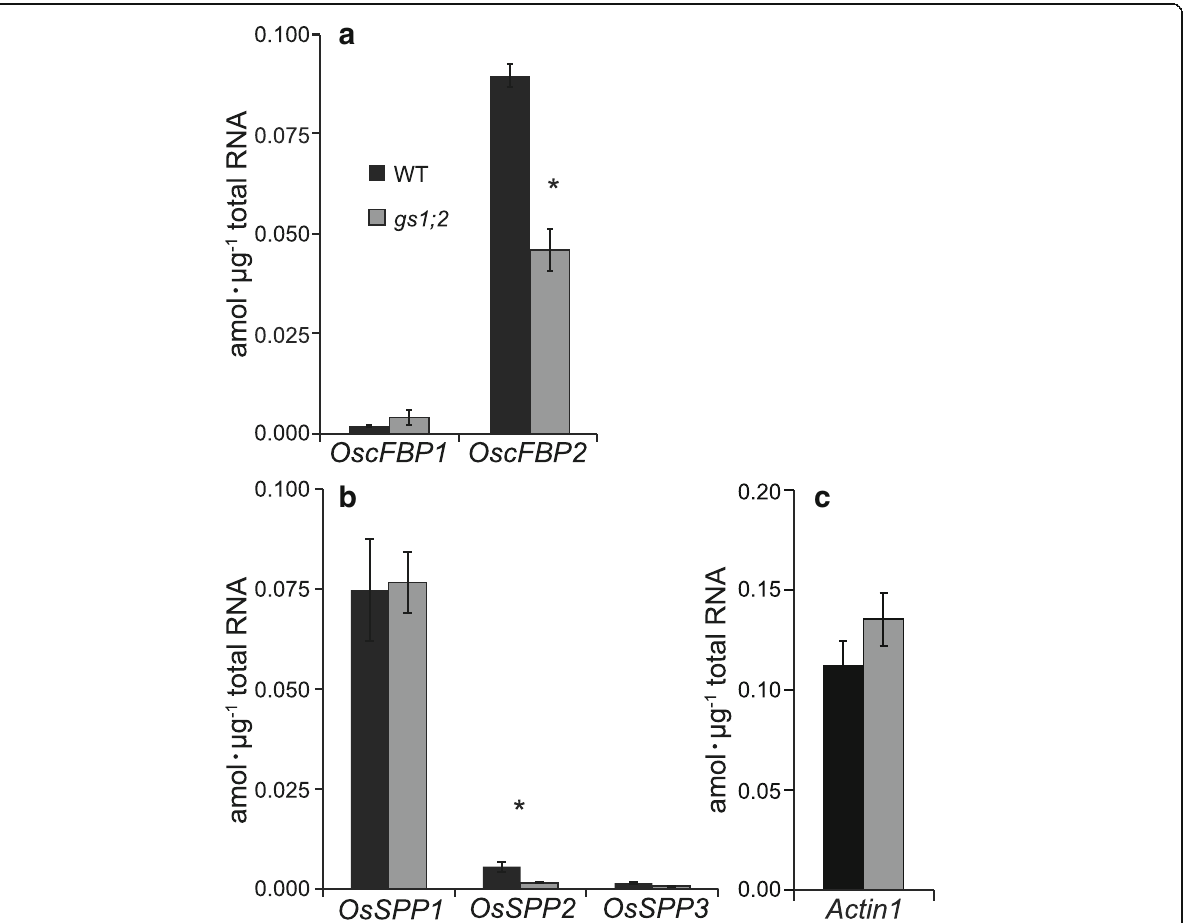
Fig. 3 qPCR analysis of OscFBP and OsSPPs in the basal portions of the shoots. The qPCR analyses were performed on the OscFBP1 and OscFBP2 genes ( a ), the OsSPP1, OsSPP2 , and OsSPP3 genes ( b ) and the control Actin1 ( c ) in the basal portions of the shoots of wild-type plants (WT: black column) and gs1;2 mutants ( gs1;2 : gray column). Seedlings were grown hydroponically in the presence of 1 mM NH 4 Cl until the fourth leaf stage. Mean values with the SE for four independent plants are shown. Asterisks denote statistically significant differences between the WT and the gs1;2 mutants (*, P < 0.05 by Student ’ s t